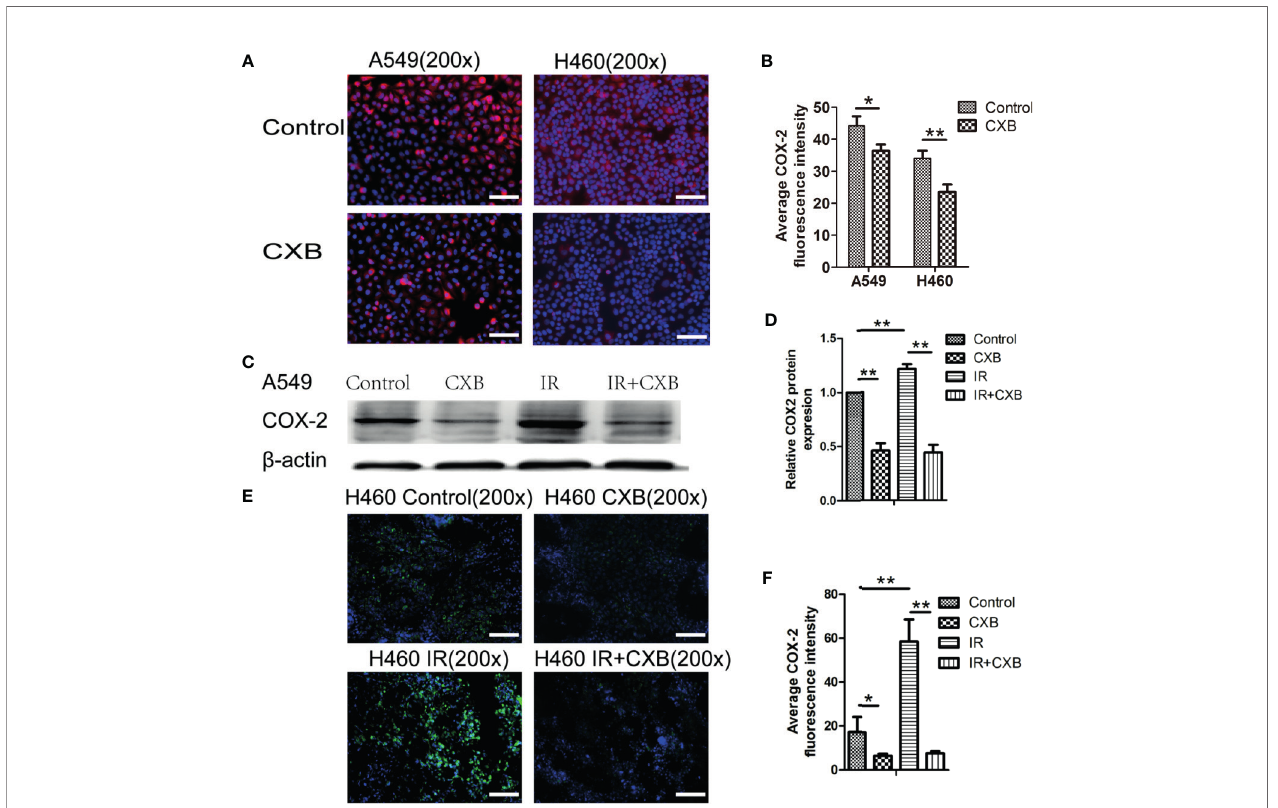
FIGURE 3 | The expression of COX-2 in cells and the in fl uence of CXB and/or IR on the expression of COX-2. (A) COX-2 immuno fl uorescence staining in A549 and H460 cells (blue, nucleus; red, COX-2). Scale bar, 100 m m. (B) Average fl uorescence intensity of COX-2 in cells. Error bars indicate standard division. COX-2 expression levels in A549 and H460 cells were signi fi cantly decreased by CXB. * p < 0.05, ** p < 0.01. (C) COX-2 protein expression in A549 cells analyzed by Western blotting (picture was cropped). (D) The relative COX-2 protein expression in A549 cells. ** p < 0.01. (E) COX-2 immuno fl uorescence staining in tumor tissues from BALB/c nude mice (H460, n = 6; blue, nucleus; red, COX-2). Scale bar, 100 m m. (F) Average fl uorescence intensity of COX-2 in tumor tissues from BALB/c nude mice (H460, n = 6). Error bars indicate standard division. * p < 0.05, ** p < 0.01. COX-2, cyclooxygenase-2; CXB, celecoxib; IR, irradiation.